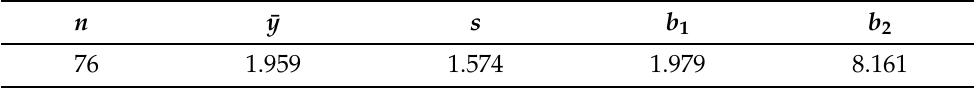
Table 3. Statistical summaries for fatigue data of Kevlar 373/epoxy.